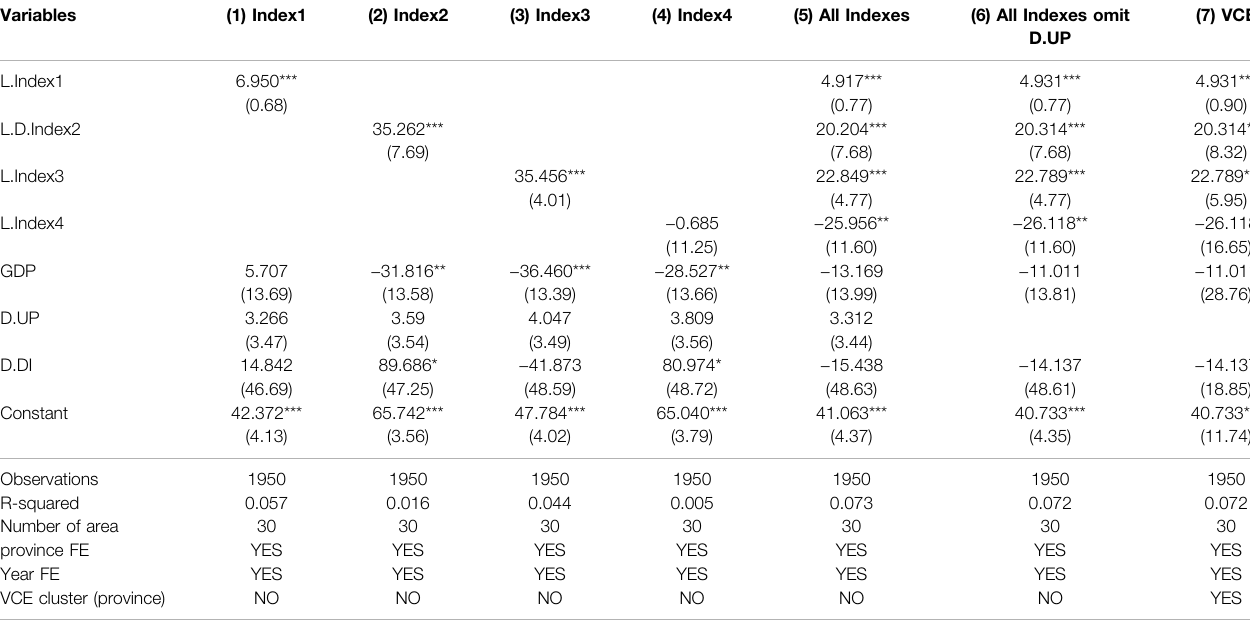
TABLE 5 | Model estimation results using Baidu search index of 1 month ahead. Variables